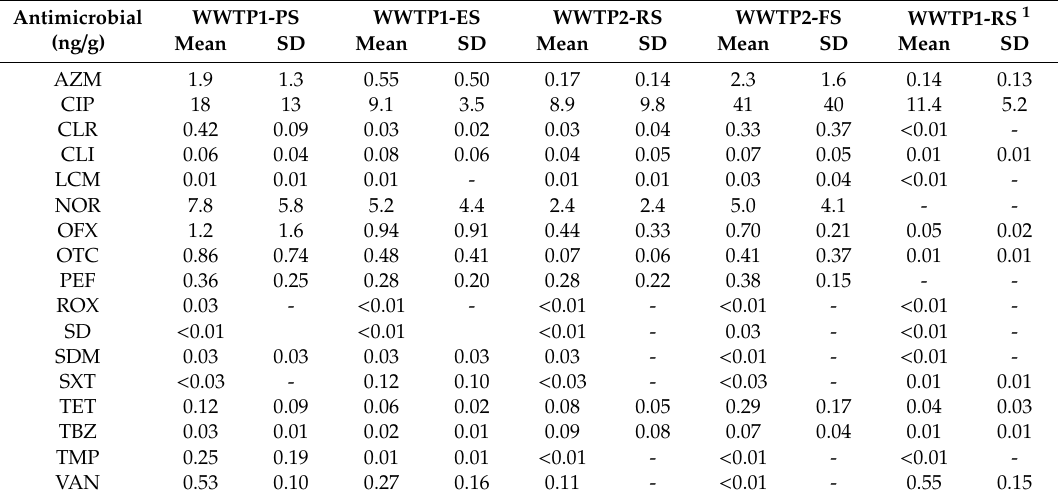
Table A3. Predicted antimicrobial concentration in sludge-amended soil (single sludge application). Antimicrobial (ng / g)